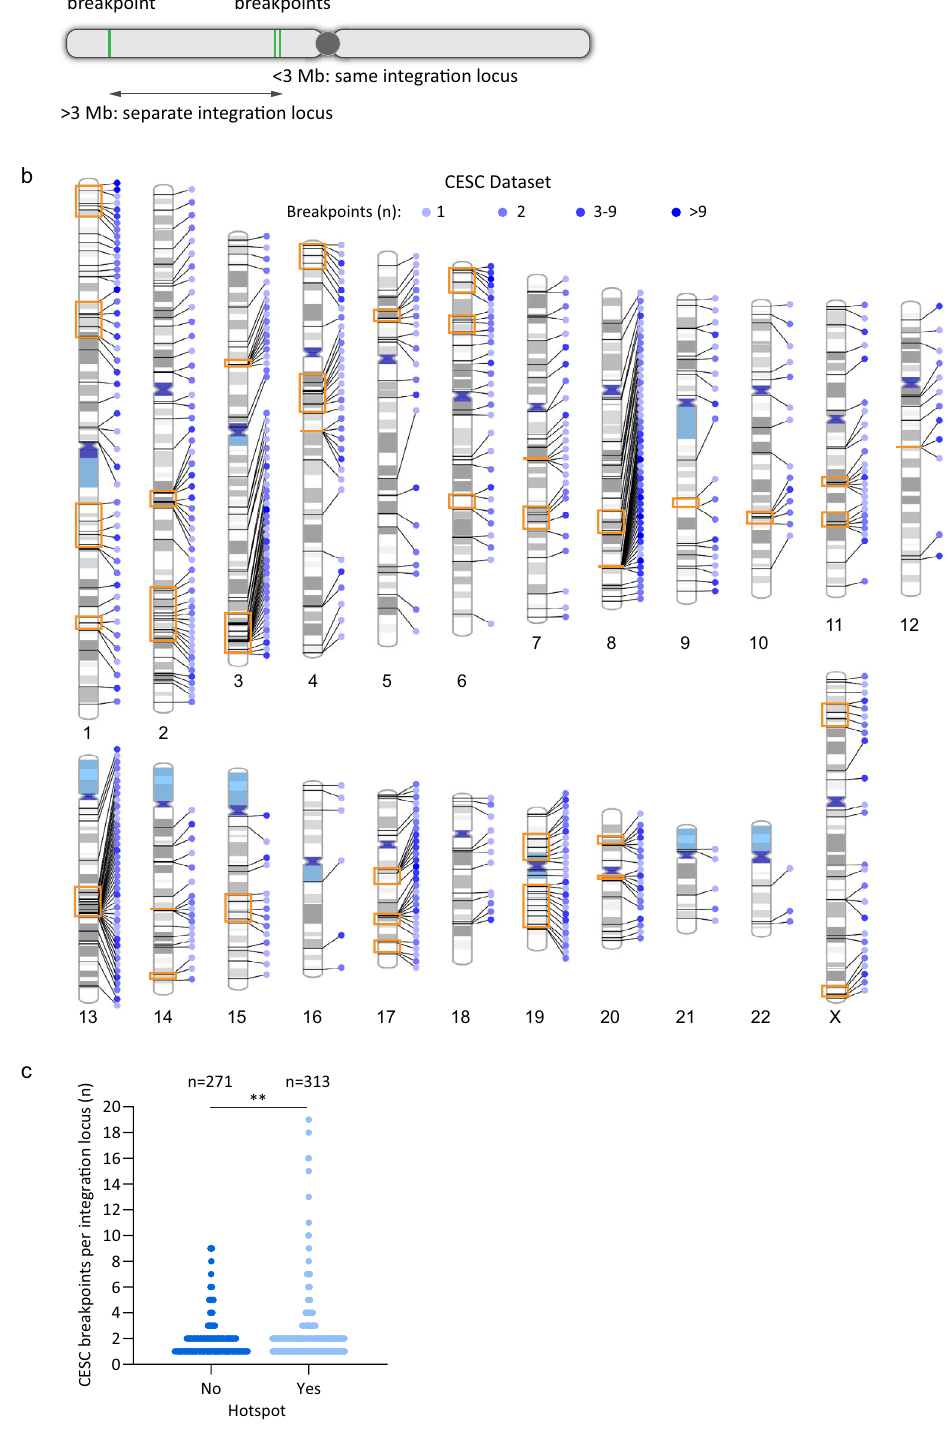
35). The transcription status of each integration locus is indicated in Supplementary Data Tables 2 and 3. Integration loci in which no viral – host chimeric junctions were detected by RNA sequencing (RNA-seq) analysis were classi fi ed as inactive or passenger loci. In CESC, all samples with a single integration locus ( n = 86)